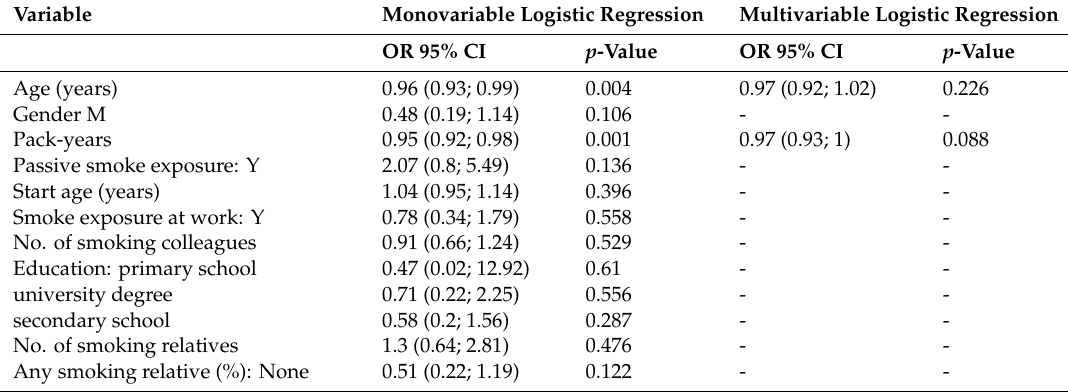
Table 3. Monovariable and multivariable logistic regression estimate (OR 95% CI) in active smokers for the previous attempt to quit